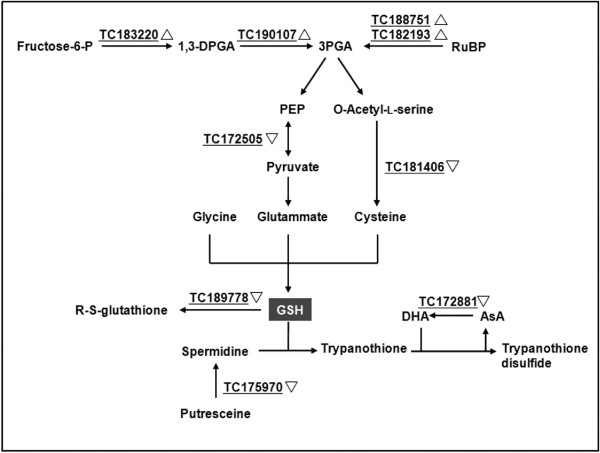
Network showing the differential expression (between IL 12-4 and M82) of genes associated with the glycolytic pathway and glutathione metabolism. Underlined TCs are differentially expressed in the microarray experiment, with upright triangles representing upregulation and inverted triangles representing downregulation. Abbreviations: 1,3-DPGA, 1,3-diphosphoglyceric acid; 3PGA, 3 phosphoglyceric acid; RuBP, Ribulose 1,5-biphosphate; PEP, phosphoenolpyruvic acid; GSH, glutathione; DHA, dehydroascorbic acid.